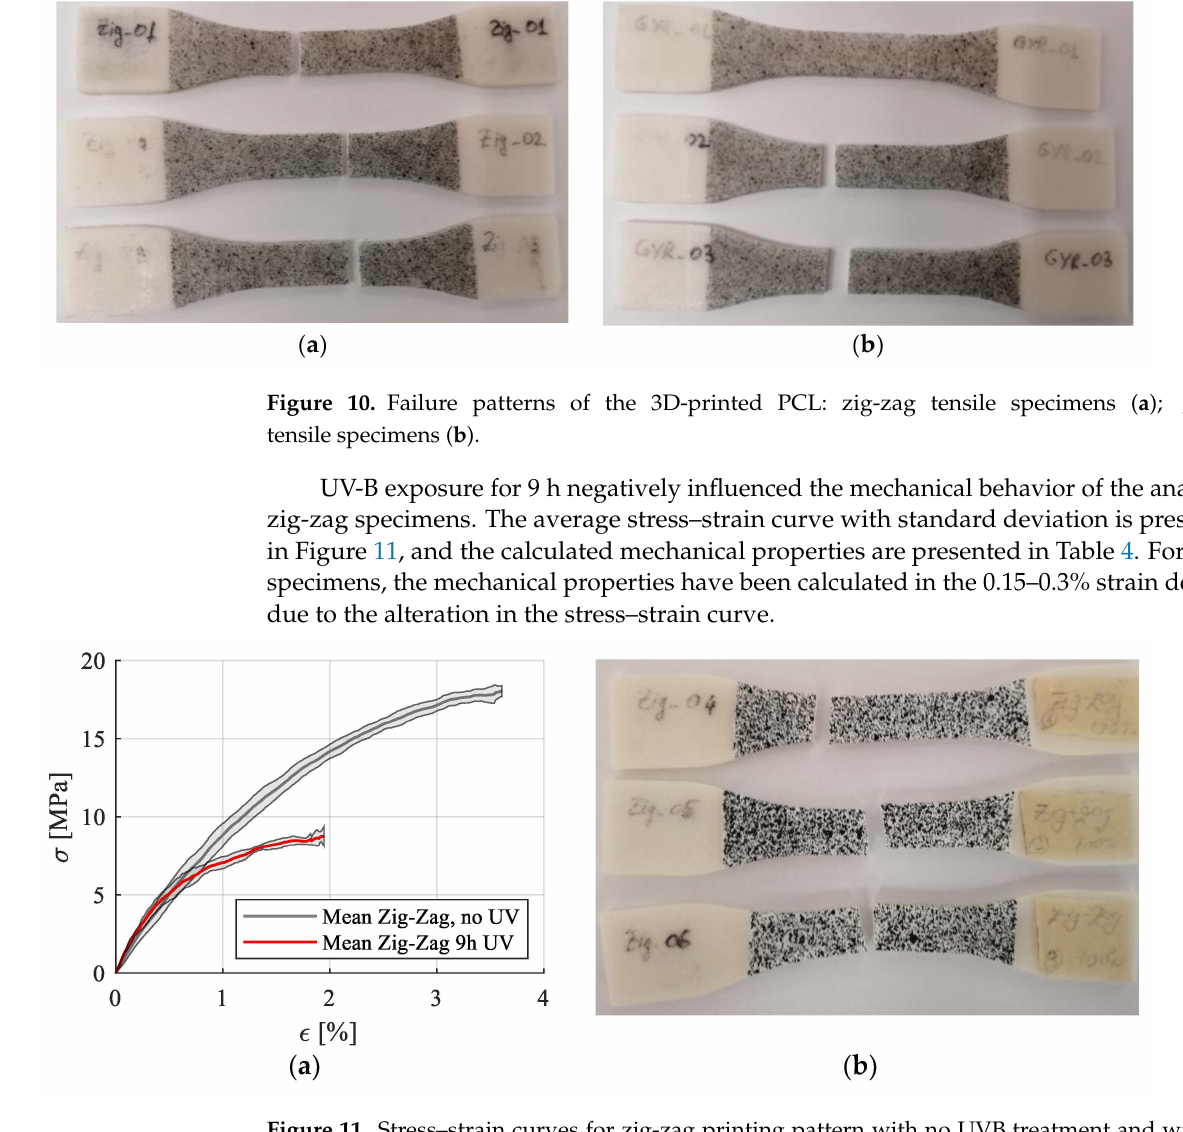
Figure 11. Stress–strain curves for zig-zag printing pattern with no UVB treatment and with UV treatment ( a ); Failure patterns for the UV-B treated samples ( b ). Table 4. Mechanical properties of UV-B irradiated PCL